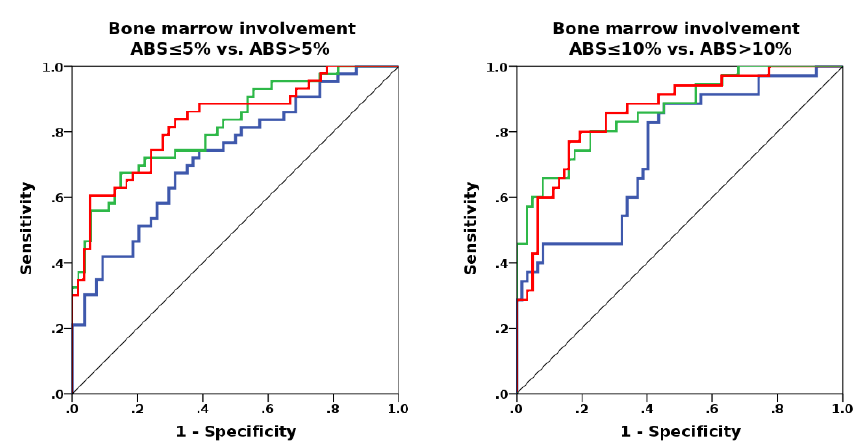
Figure 1. Areas under the receiver operating characteristic curve for standardized uptake values (SUVs) alone; the radiomic signature (SUVs and gray-level co-occurrence matrix (GLCM) features); the radiomic signature combined with laboratory data (WBC and LDH); for assessment of bone marrow involvement. Performance generally improves with the percentage of relative or absolute bone marrow involvement (REL and ABS), but more prominently for the radiomic signature, with and without combination with laboratory data.